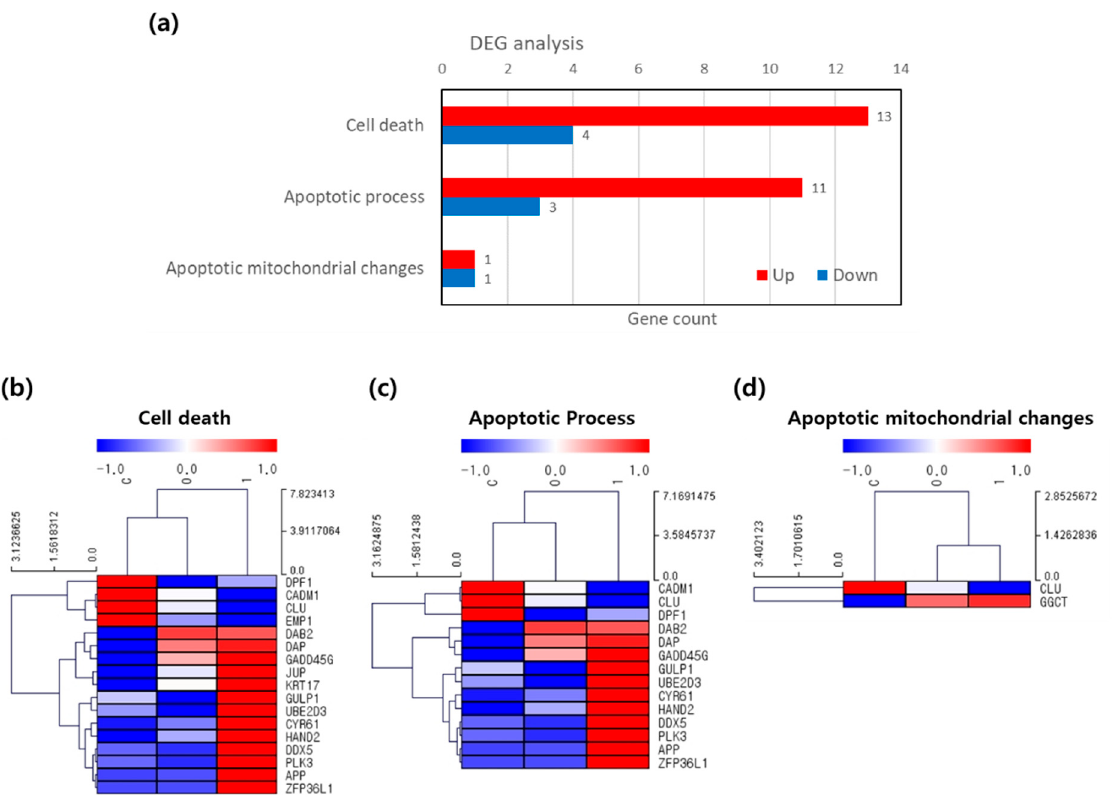
Figure 6. Analysis of mRNA expression related to cell death and apoptotic process in HeLa cells. ( a ) Differentially-expressed gene (DEG) analysis. ( b ) Clustering heatmap for cell death, ( c ) apoptotic process, and ( d ) apoptotic mitochondrial changes in HeLa cells. DEG analysis and mRNA expression were determined by Ampli-Seq sequencing after 40 mW PDT for 10 min and 0 and 1 hr incubation. The fold change (FC) and p-value cutoffs were as follows: FC: > 1.5 and p -value: < 0.1.